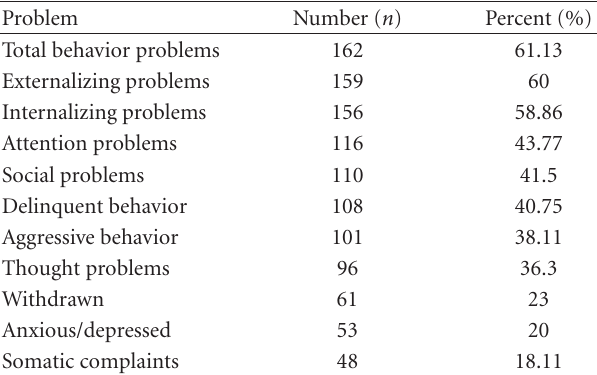
Table 3: Children identified by the caregivers using CBCL to have behavioral problems.